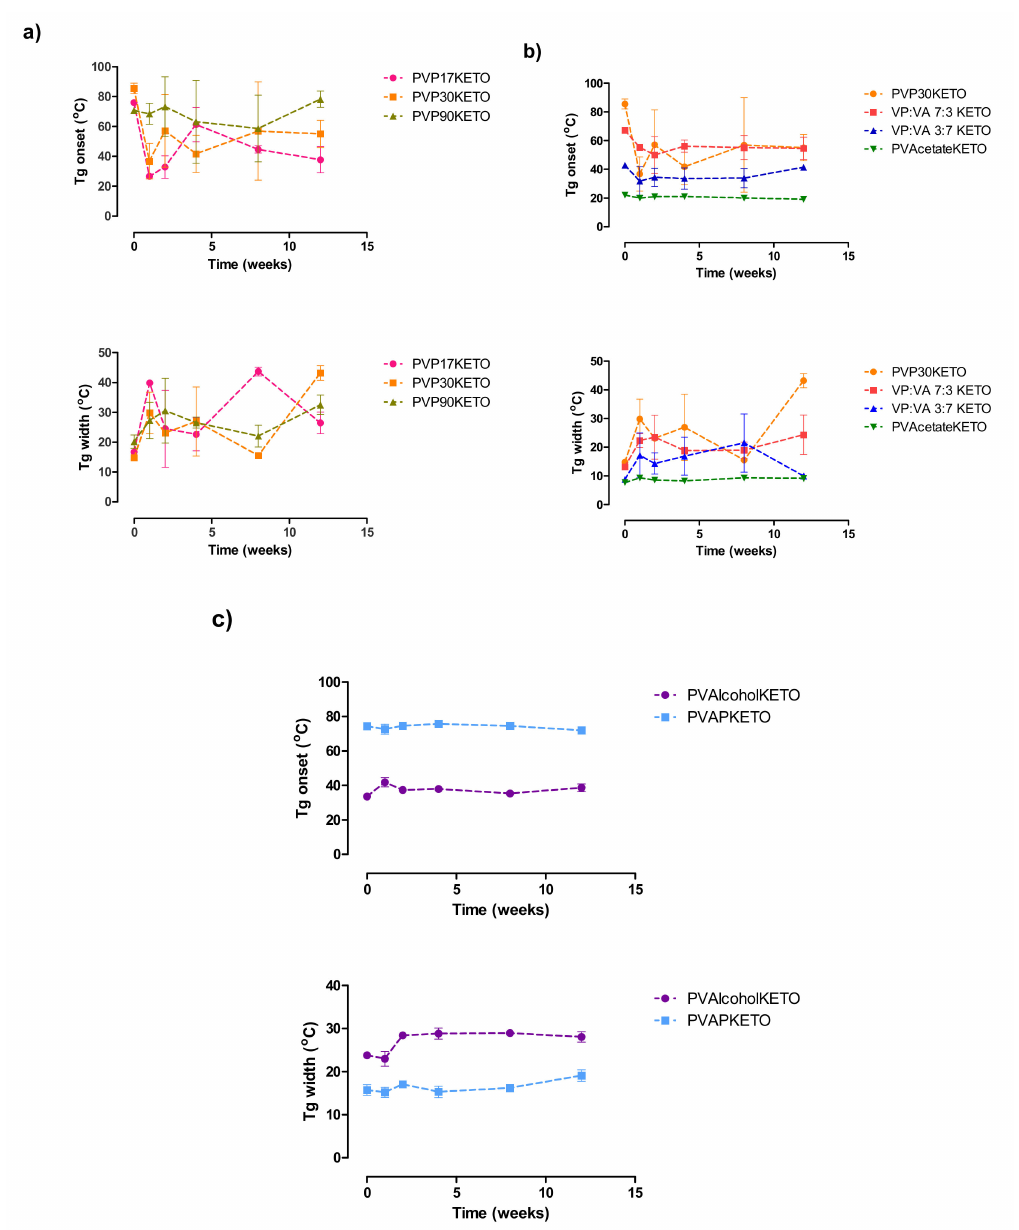
Figure 11. Glass transition onset temperatures and glass transition temperature width of ( a ) PVPKETO, ( b ) VP:VA KETO and ( c ) PVAlcoholKETO and PVAPKETO systems stored at 75% RH at 25 ◦ C for 12